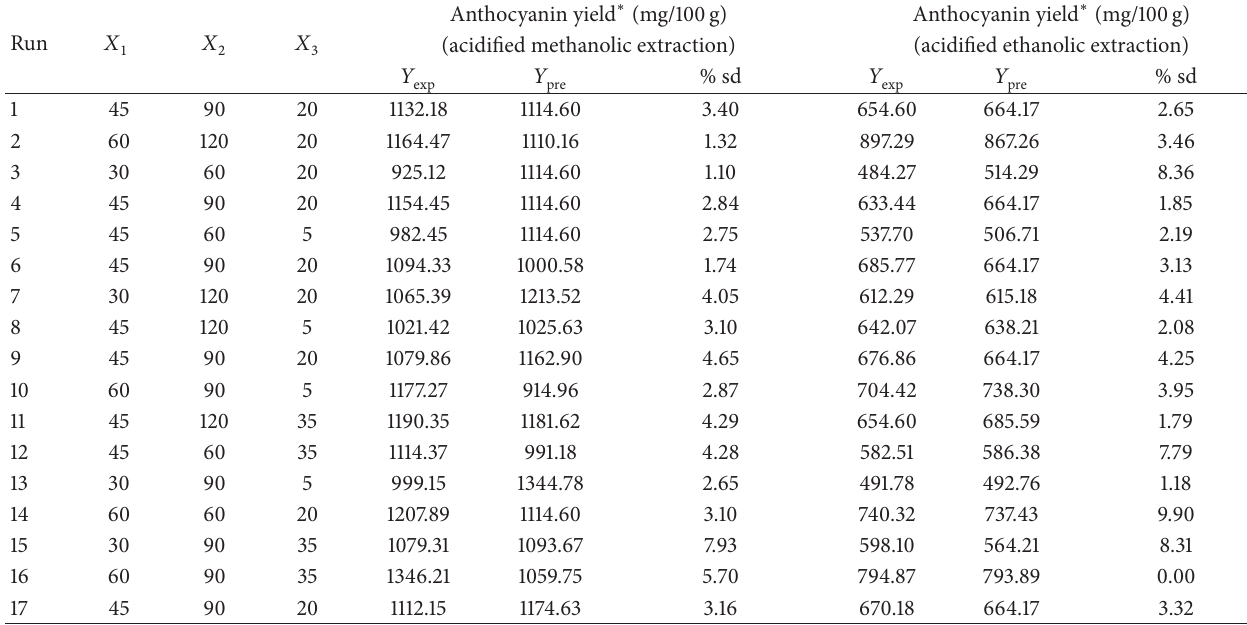
Table 4: Box-Behnken design arrangement and responses.